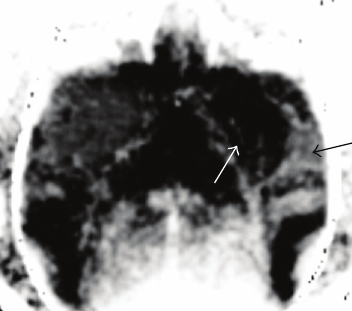
Figure 10: 1h R2 (cid:2) map shows low signal of irreversible infarcted core (white arrow), slightly high signal of reversible IP (black arrow).